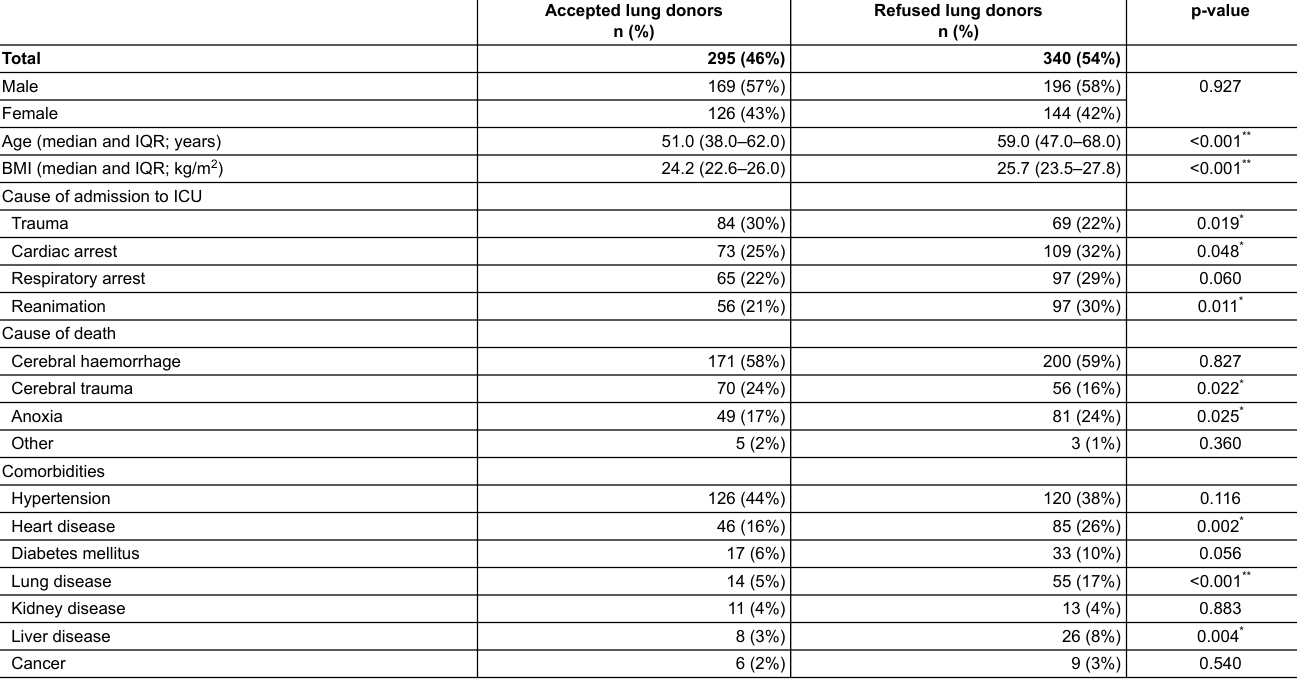
Table 1: Donor baseline characteristics for accepted and refused lung